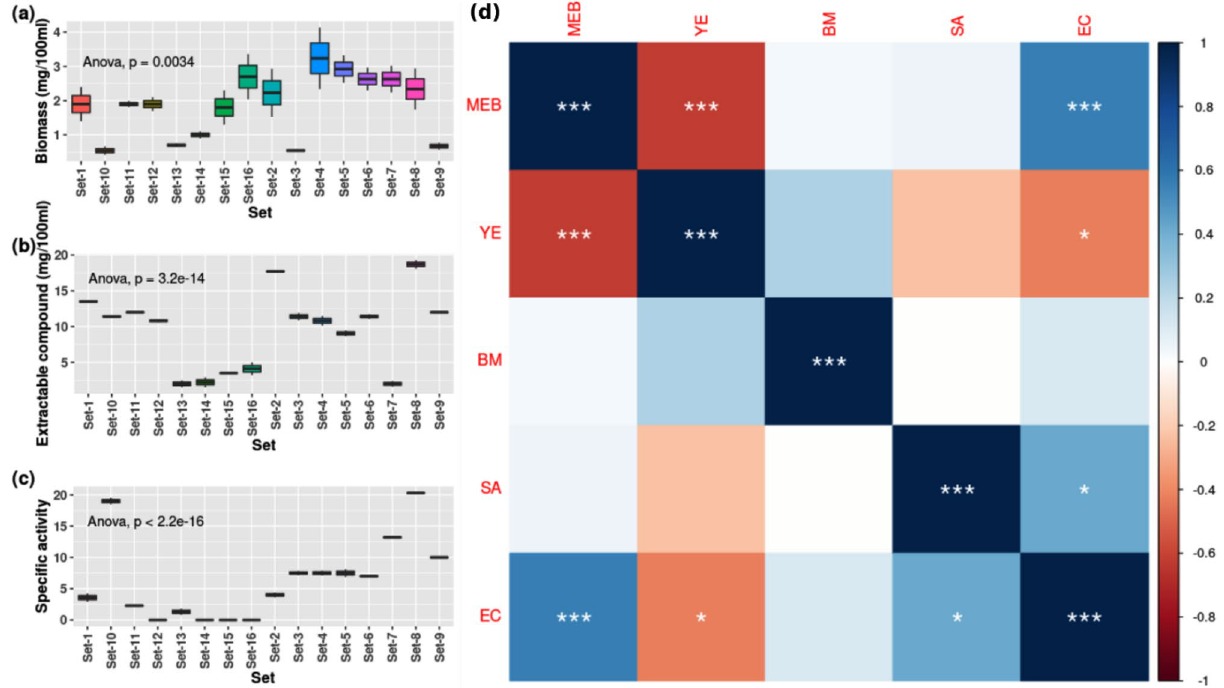
Figure 2. Box plots ( a – c ) represent the data distribution range of biomass (BM), extractable compound (EC), specific gravity (SA) and variation between experimental sets. Correlation matrix ( d ) represents the correlation between parameters [Colour scale bar at right representing correlation from negative (− 1) to positive (+ 1). Significance stars representing significance level of correlation (*p < 0.05, **p < 0.01, ***p <